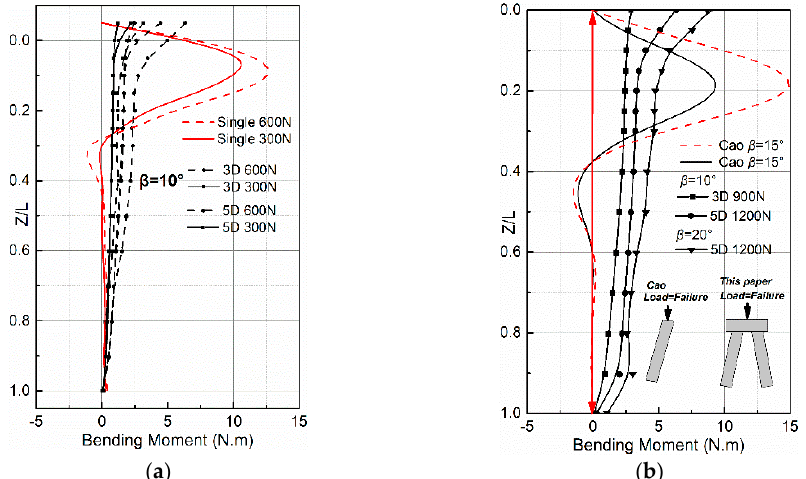
Figure 12. The comparison of bending moments between the single and the symmetrical batter piles under vertical loading. The comparison between the symmetrical and the single batter piles of ( a ) this paper and ( b ) Cao [17], under the failure load.